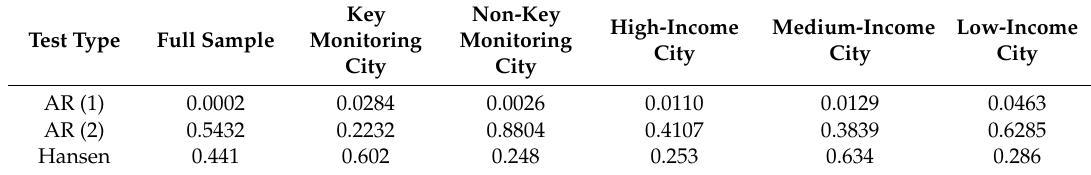
Table 2. System GMM estimation results and the instrumental variable validity test.